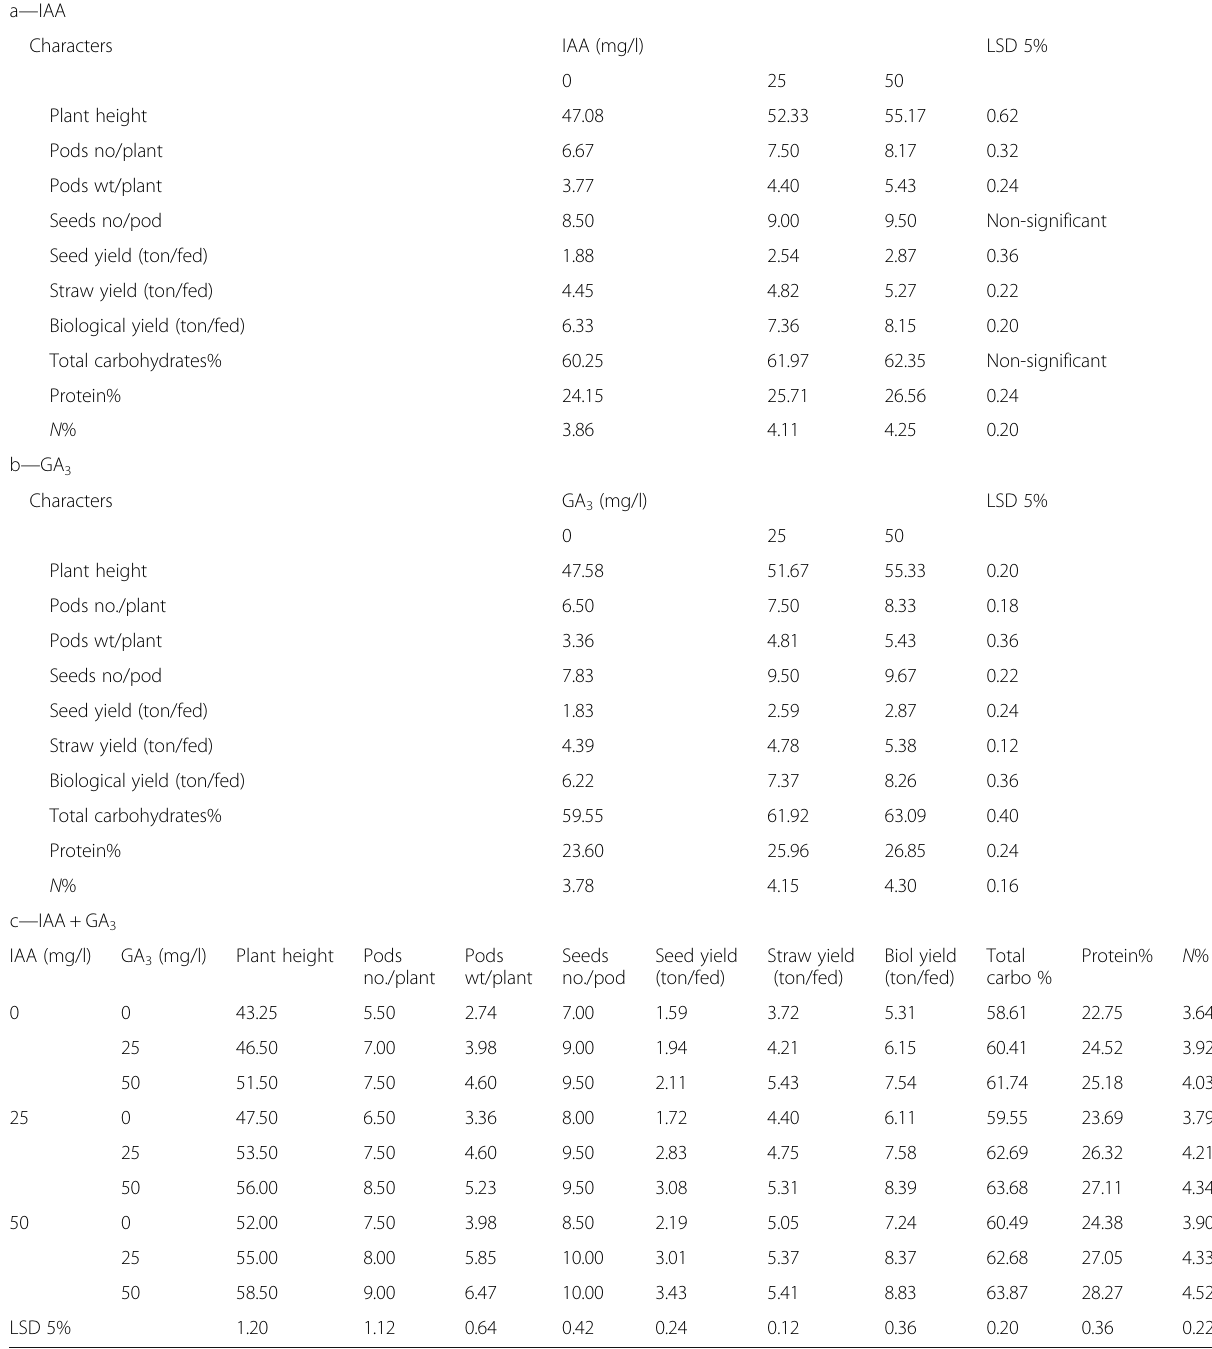
Table 5 Effect of IAA (a) or GA 3 (b), and IAA + GA 3 (c) (0, 25, and 50 mg/l) on yield, yield attributes, and chemical values of mungbean plant grown under sandy